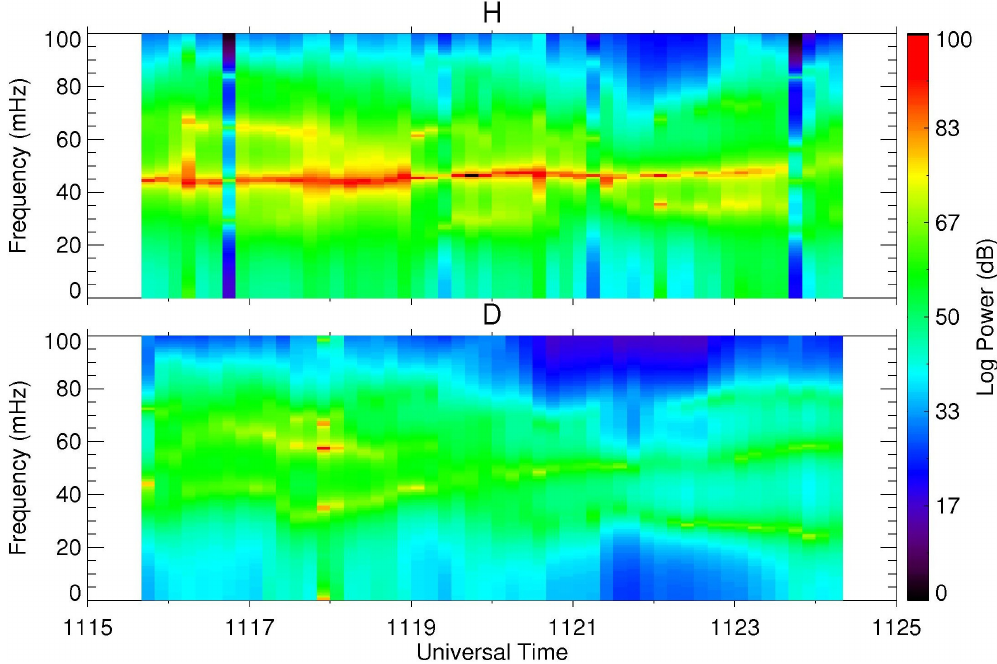
Fig. 5a. MESA ground dynamic spectra for the H- and D-components observed at Hermanus on 15 February